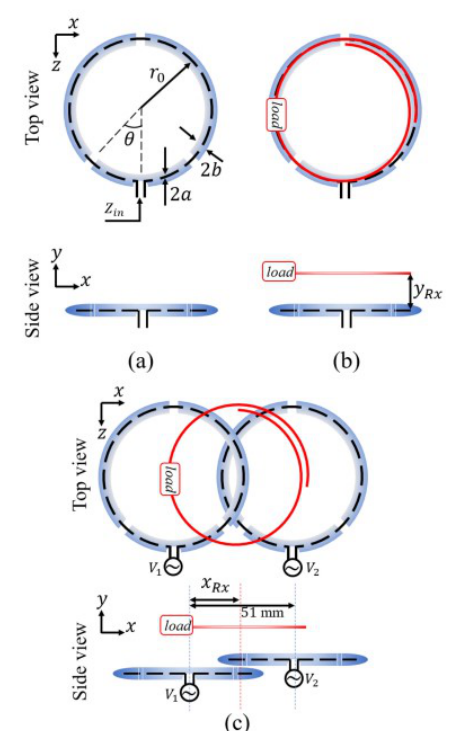
Figure 13. ( a ) Concept and ( b ) structure of the metasurface-based WPT presented in [37]. Last but not the leastm with the aim to reduce the overall size of the WPT system, Bao et al. presented a planar multilayer elements SCMR WPT system [16]; its general structure is shown in Figure 15. Their results show that for the targeted efficiency is obtained with a 50% area reduction.